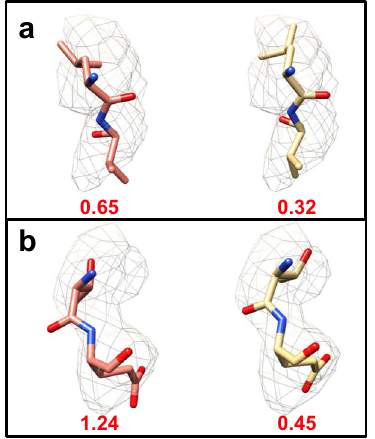
Fig. 2 Improvement in the fi t of the structure of the spike glycoprotein of SARS-CoV-2 in the closed state (EMD-21452). In each panel, the left side shows the original fi t and the right side shows the improved fi t, using ISOLDE 16 . a Fragment composed of amino acids LEU-533 and VAL-534, and b THR-323 and GLU-324. Under each fragment, the average FSC- Q is shown.